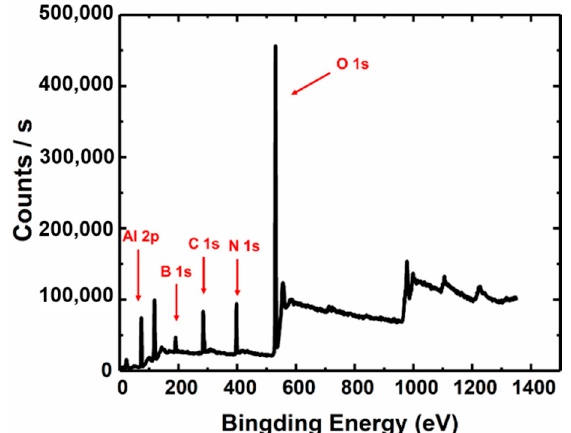
Figure 7. XPS results of h-BN/sapphire substrate.